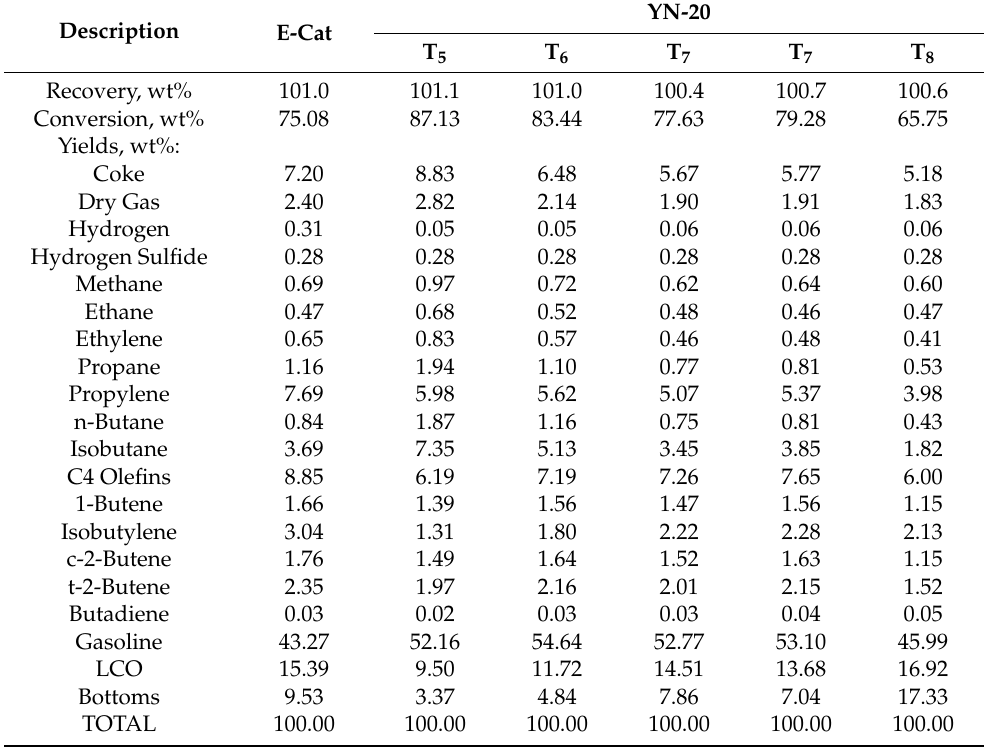
Figure 1. Product distributions of equilibrium catalyst (E-Cat) and Cat.2 at new serial hydrothermal conditions. Table 5. Catalytic activity (wt. %) for Cat.2 under Modified Conditions.